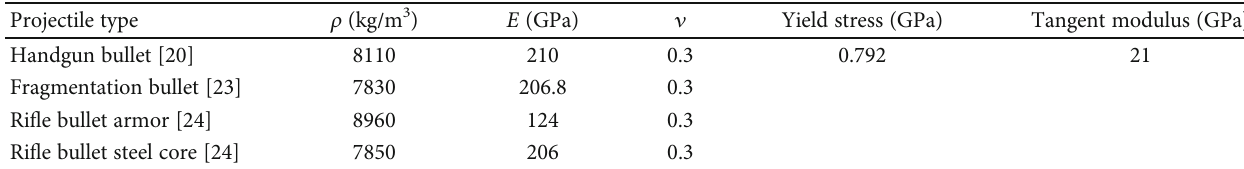
Figure 1: Bullet-proof helmet model and bullet model. Table 1: Bullet material